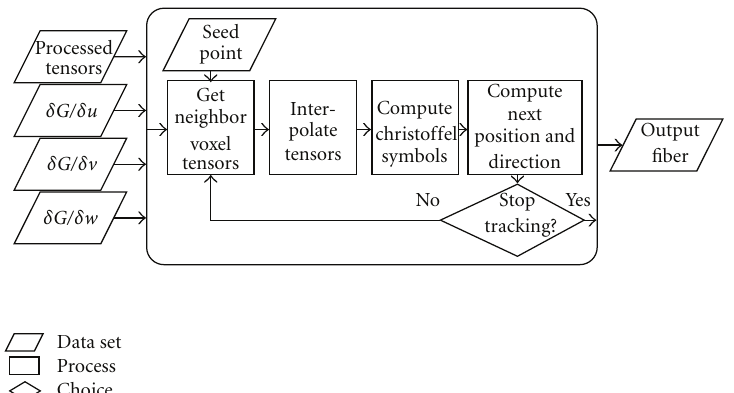
Figure 4: Flowchart for the geodesic fiber tracking algorithm. Using the four input tensor fields, we compute the trajectory of a fiber using a numerical ODE